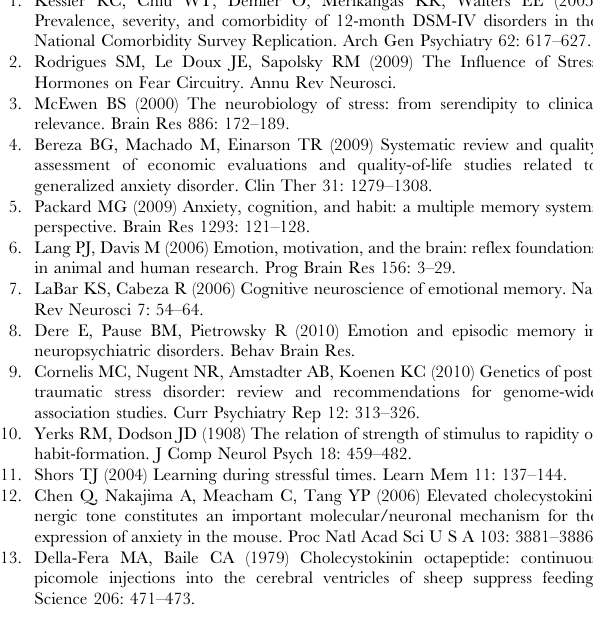
Figure S1 Transgene constructs for generation of transgenic mice. (A). Expression cassette for CaMK-II-tTA transgenic mice. The tTA is flanked by an SV-40 intron/exon Expression cassette for tetO-CCKR-2 transgenic mice.